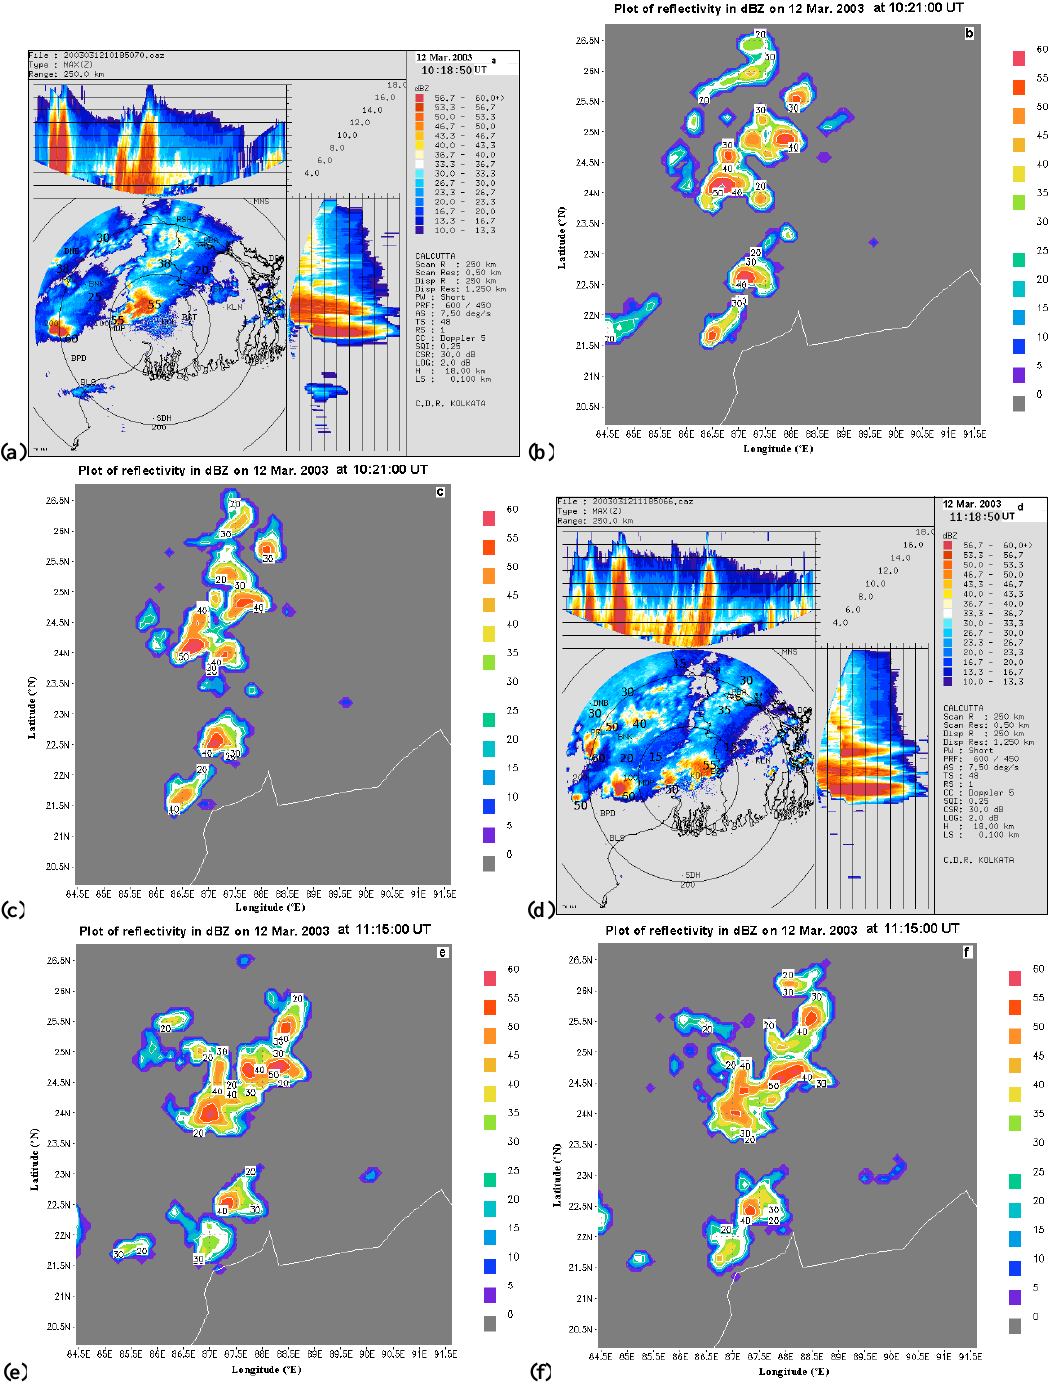
Fig. 5. (a) DWR derived reflectivity Max(Z) at 10:18UT, 12 March 2003. (b) Model simulated reflectivity with default cloud microphysics at 10:21UT, 12 March 2003. (c) Model simulated reflectivity with modified cloud microphysics at 10:21UT, 12 March 2003. (d) DWR derived reflectivity Max(Z) at 11:18UT, 12 March 2003. (e) Model simulated reflectivity with default cloud microphysics at 11:15UT, 12 March 2003. (f) Model simulated reflectivity with modified cloud microphysics at 11:15UT, 12 March 2003.